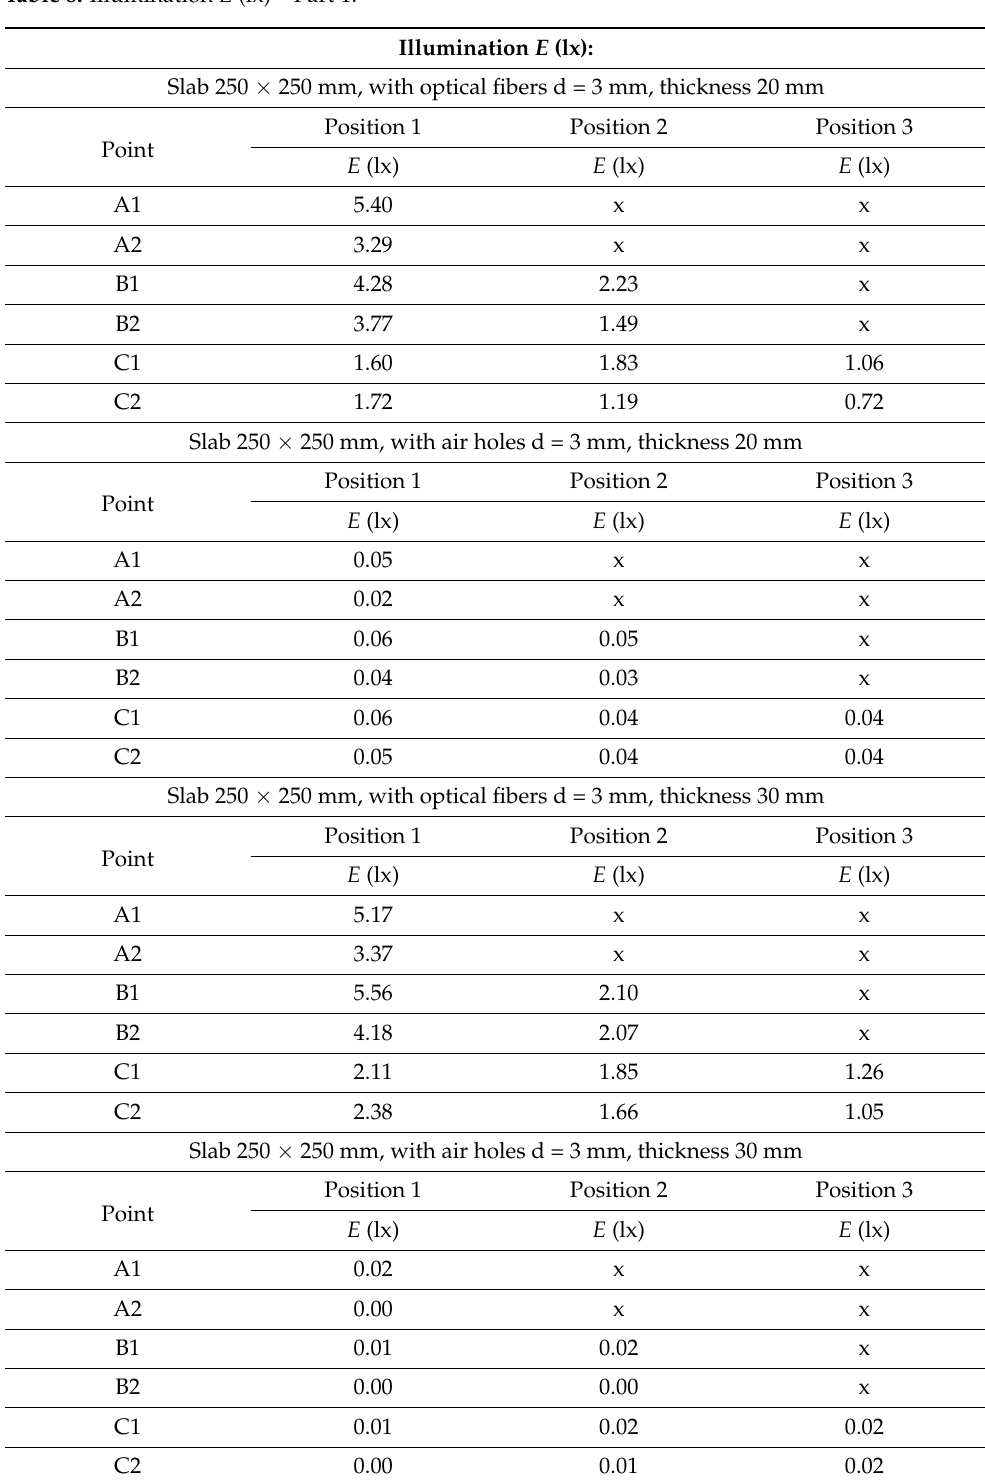
Table 8. Illumination E (lx)—Part 1.